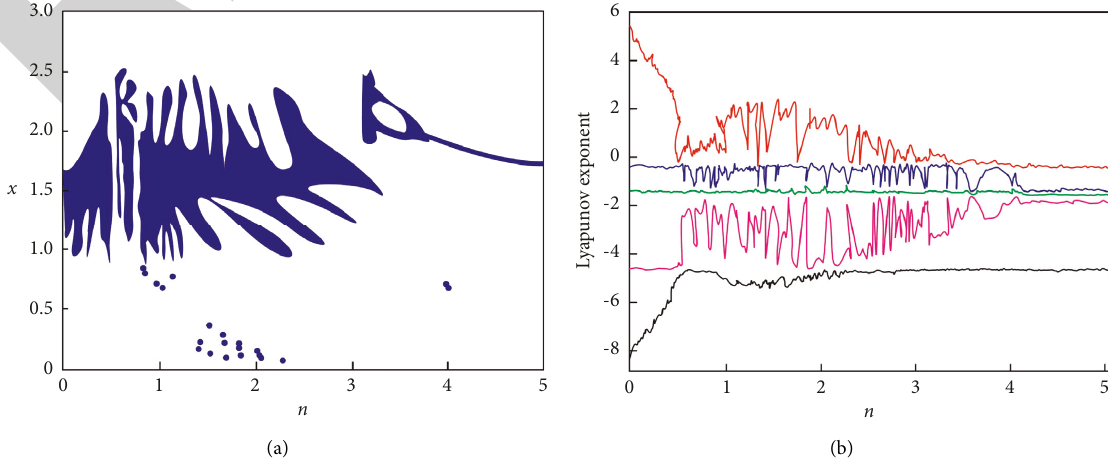
Figure 3: The system shows the branch diagram and Lyapunov index spectrum that vary according to the parameter n : (a) branch diagram; (b) Lyapunov exponent